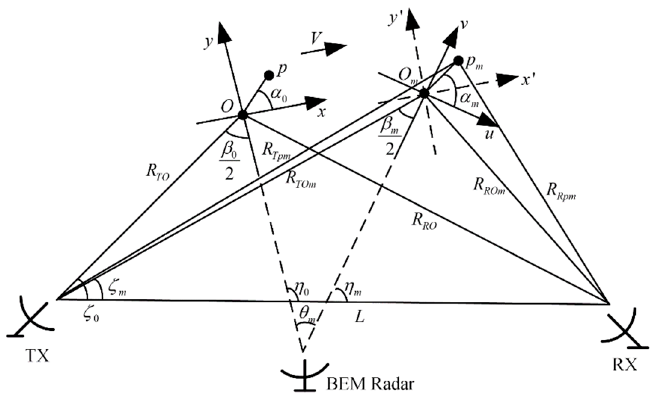
Figure 1. Geometry of bistatic ISAR imaging system.